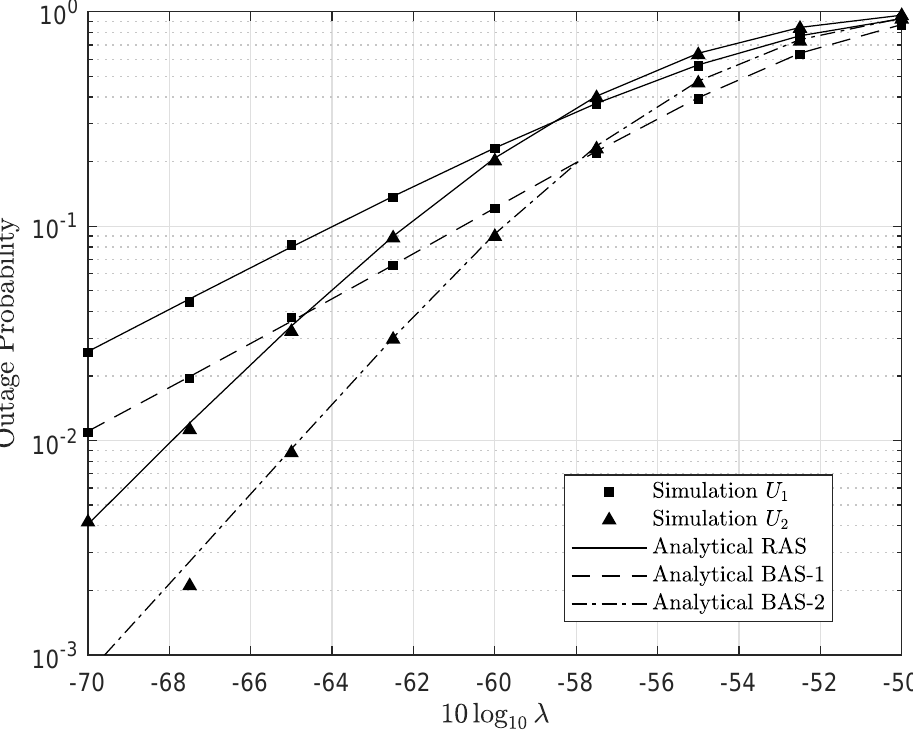
Figure 6. Outage Probability at each user versus the interferer density, where λ = λ 1 = λ 2 and ¯ γ =